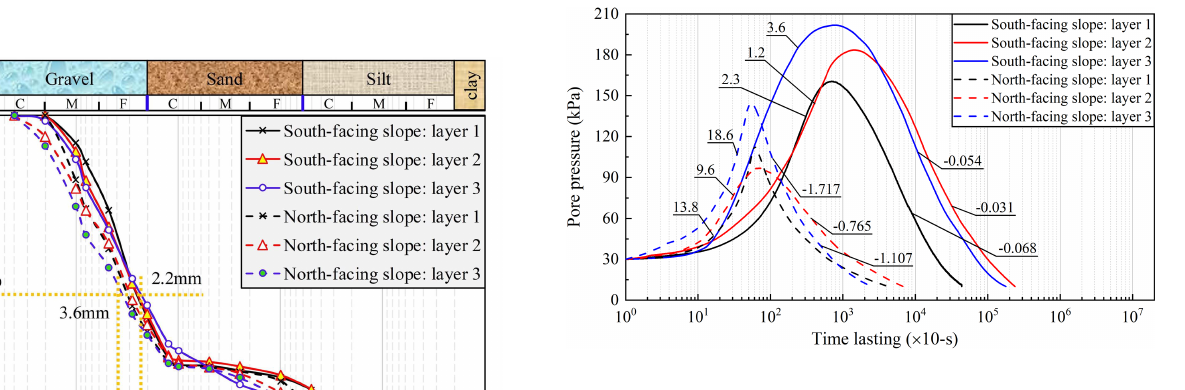
Figure 6. Variation in pore water pressure under an effective con- fining pressure of 200kPa by GDS triaxial shear tests (GDS Instru- ments, UK). The values in Fig. 6 are the average rates of the rise and dissipation of pore water pressure during consolidation calcu- lated by Eq. (2). The unit of the x axis marks the time record interval of